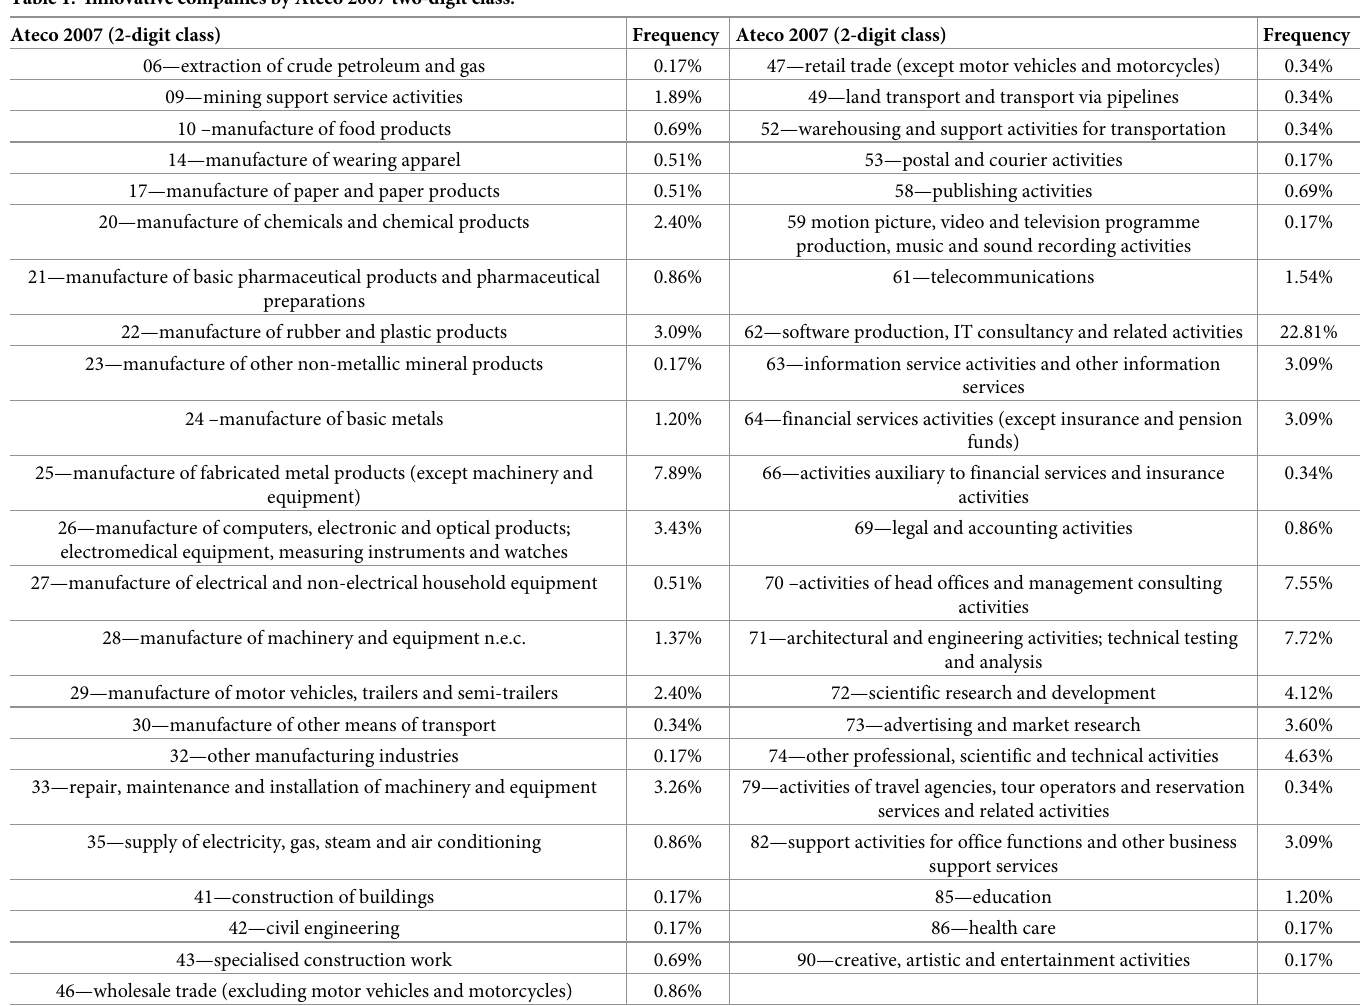
Table 1. Innovative companies by Ateco 2007 two-digit